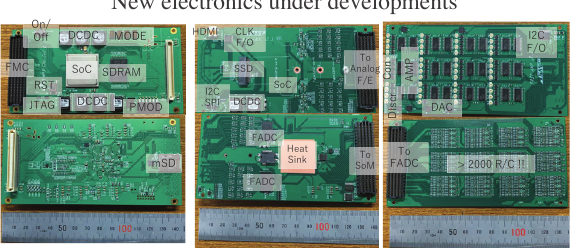
Figure 5. Developments for future stand-alone operations: the robust hut being constructed, PMT calibration system at labora- tory and the new electronics under